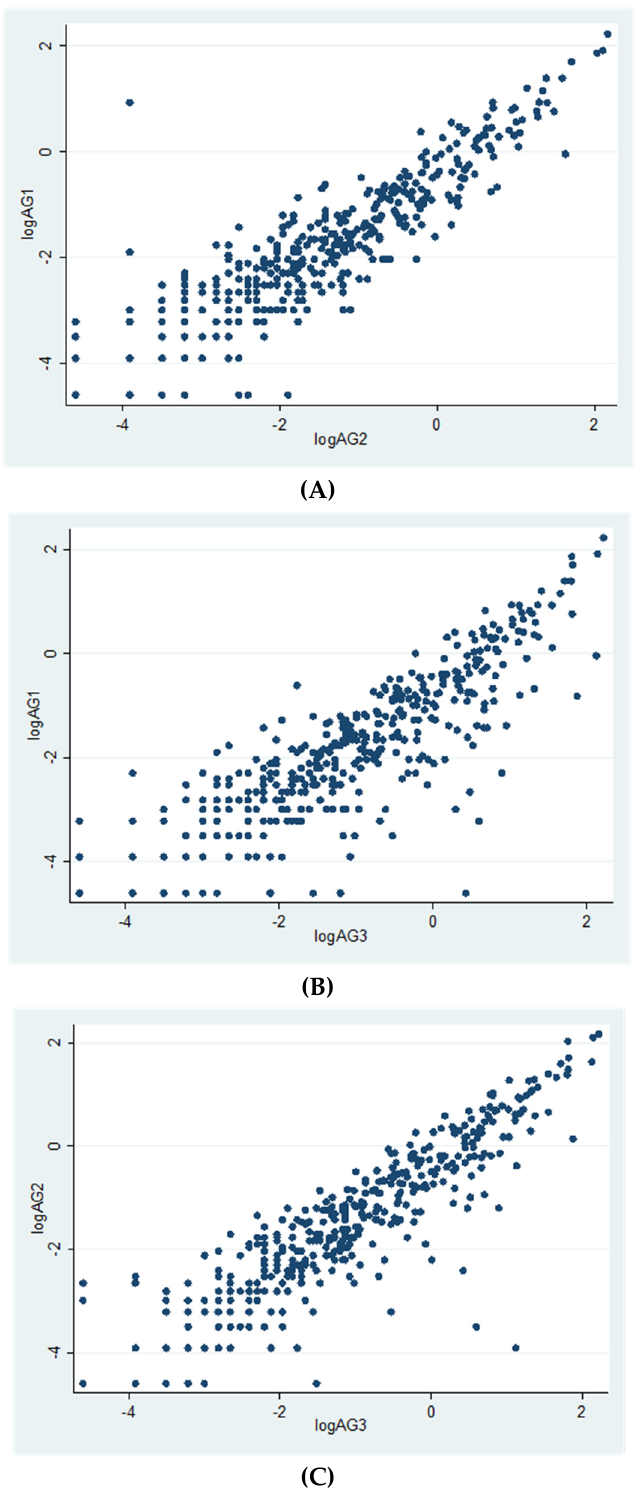
Figure 1. Correlations between Ag values (log-transformed). ( A ): logAg1 vs. logAg2 (r = 0.90, p = 0.0000); ( B ): logAg1 vs. logAg3 (r = 0.85, p = 0.0000); ( C ): logAg2 vs. logAg3 (r = 0.89, p = 0.0000).